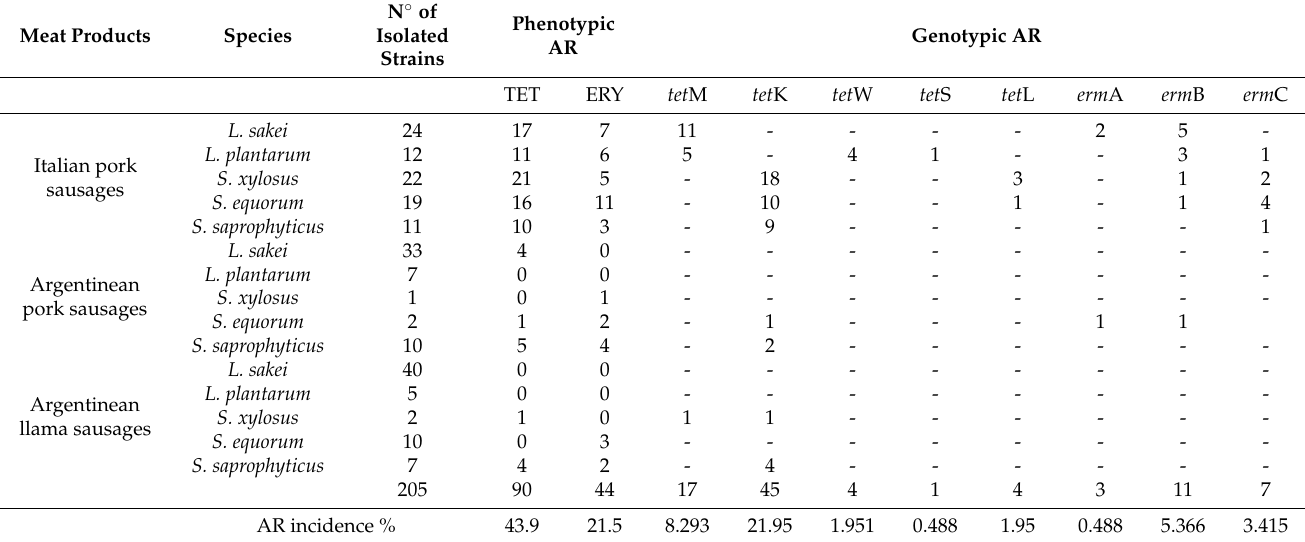
Table 2. Latilactobacillus ( L. ) sakei, Lactiplantibacillus ( L. ) plantarum and Staphylococcus ( S. ) strains included in this study. Incidence, phenotypic AR and molecular identification of antibiotic-resistant genes. Meat